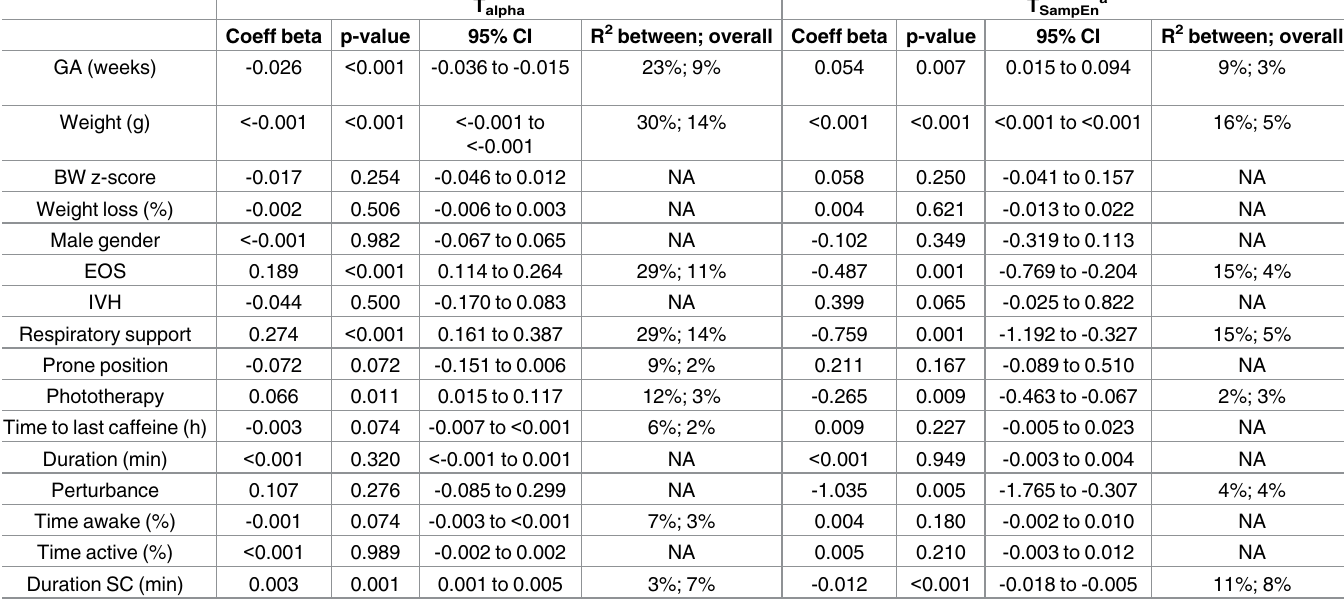
Table 3. Univariable, multilevel linear regression analysesof scaling exponent alpha and sample entropy of body temperature.